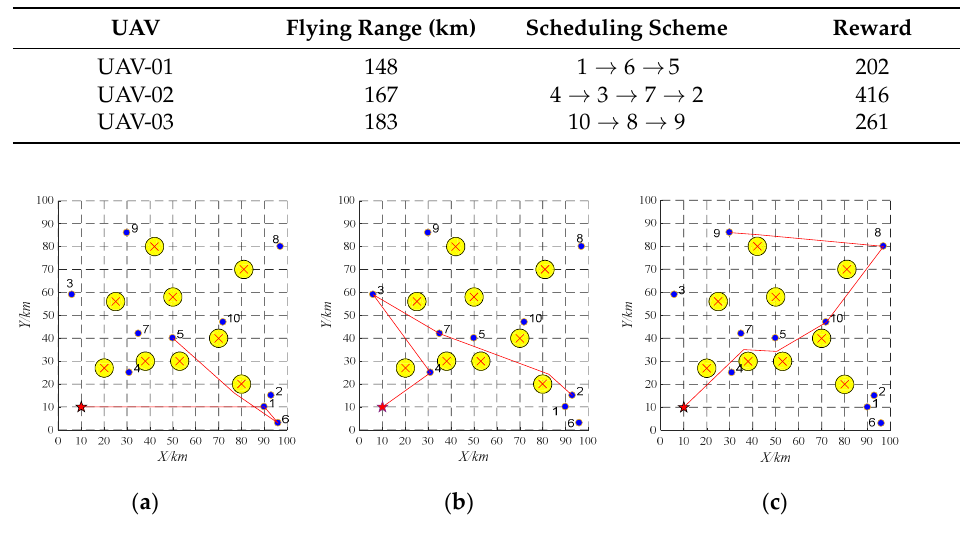
Figure 9. Offline task scheduling schemes. ( a ) UAV-01; ( b ) UAV-02; ( c ) UAV-03.